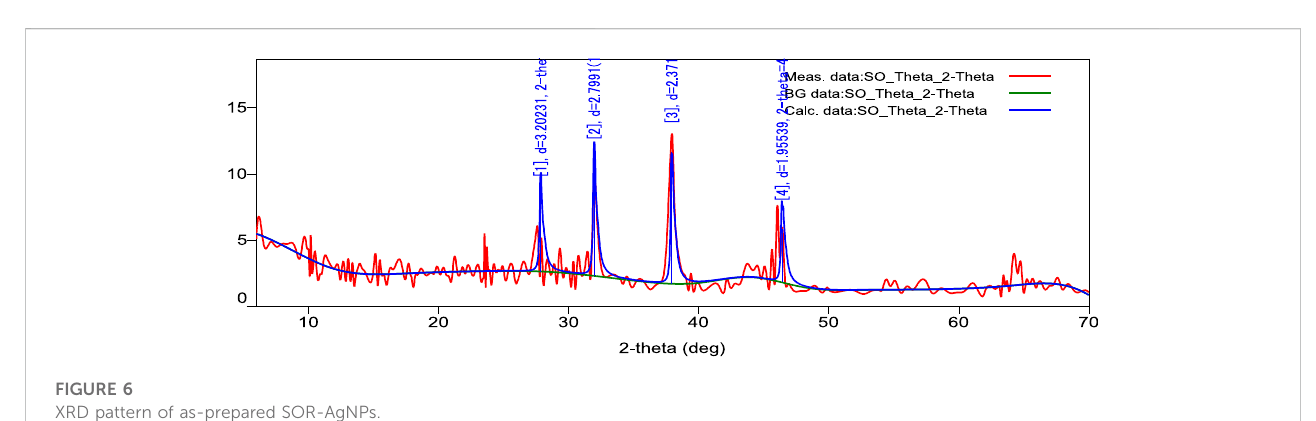
FIGURE 6 XRD pattern of as-prepared